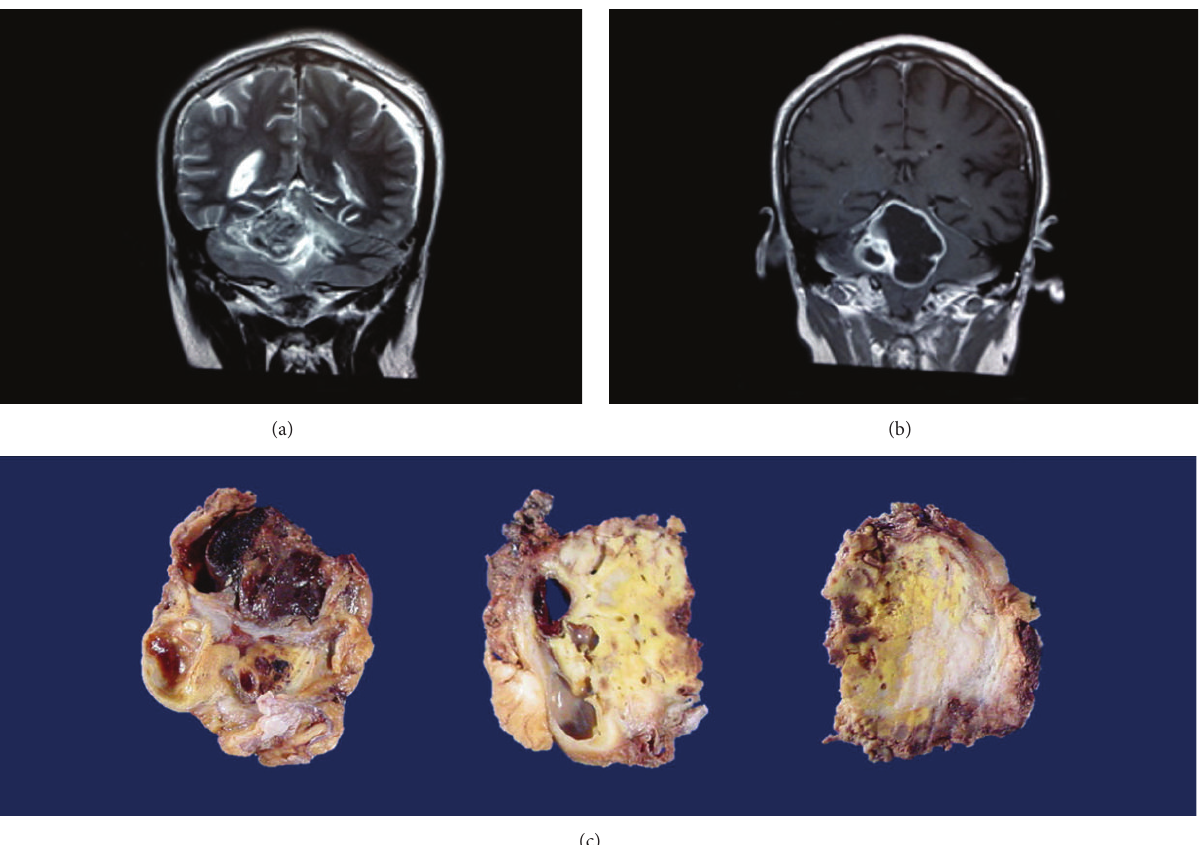
Figure 1: Magnetic Resonance Imaging Scans/Specimen Gross Findings. (a) T 2 -weighted coronal section at the time of admission. There is a predominantly solid lesion in the right cerebellar hemisphere. (b) Postcontrast T 1 -weighted image in coronal plane. A cystic component with peripheral enhancement has appeared. (c) Third specimen serial slices. Yellow-hued areas experiment sudden transition into gray-opaque zones, which microscopically corresponded to the spindled stromal cell